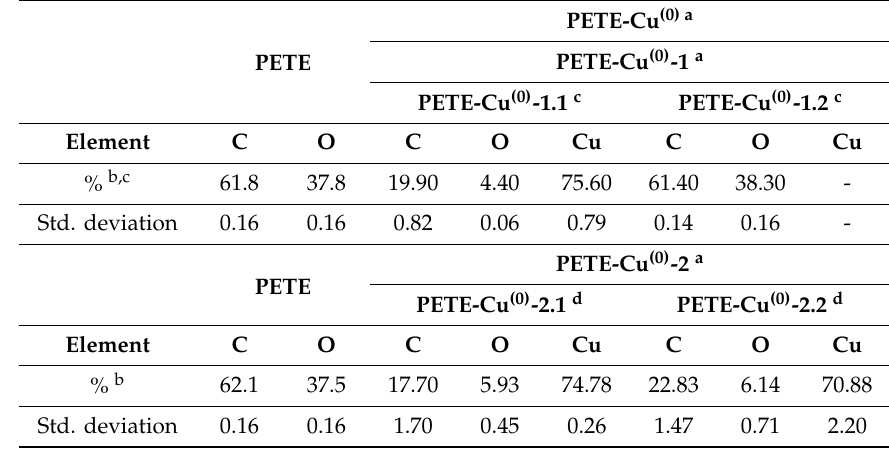
Table 1. The EDS analysis of elemental composition of PETE (C, O) and PETE-Cu (0) (C, O, Cu) composites.